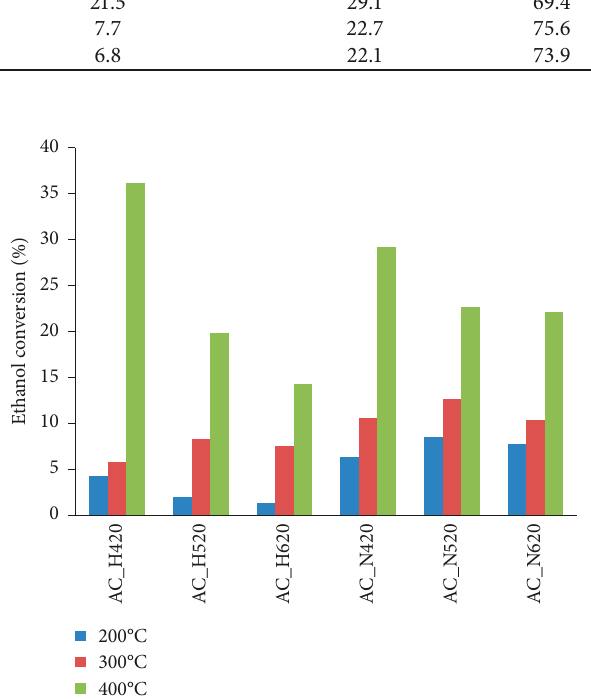
Figure 5: Ethanol conversion of the catalysts for ethanol dehydration at various temperatures.